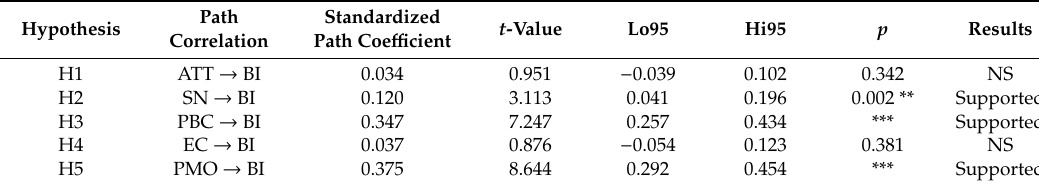
Figure 3. Path coe ffi cients and significance of the research model. Table 6. Hypotheses